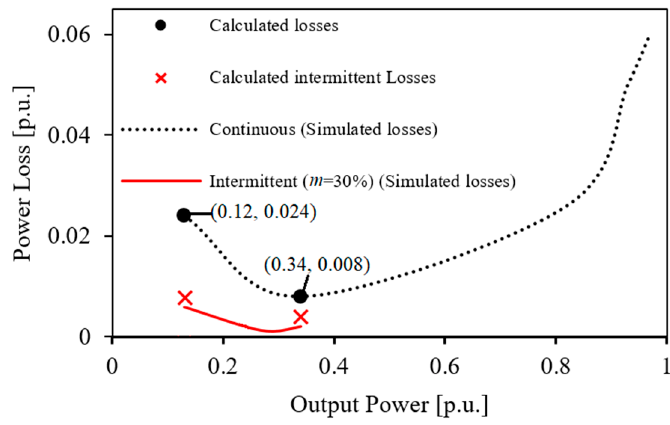
Figure 13. Output power versus power loss of the 3P-BIDC in continuous mode and intermittent mode during light-load condition with Yy transformer configuration.